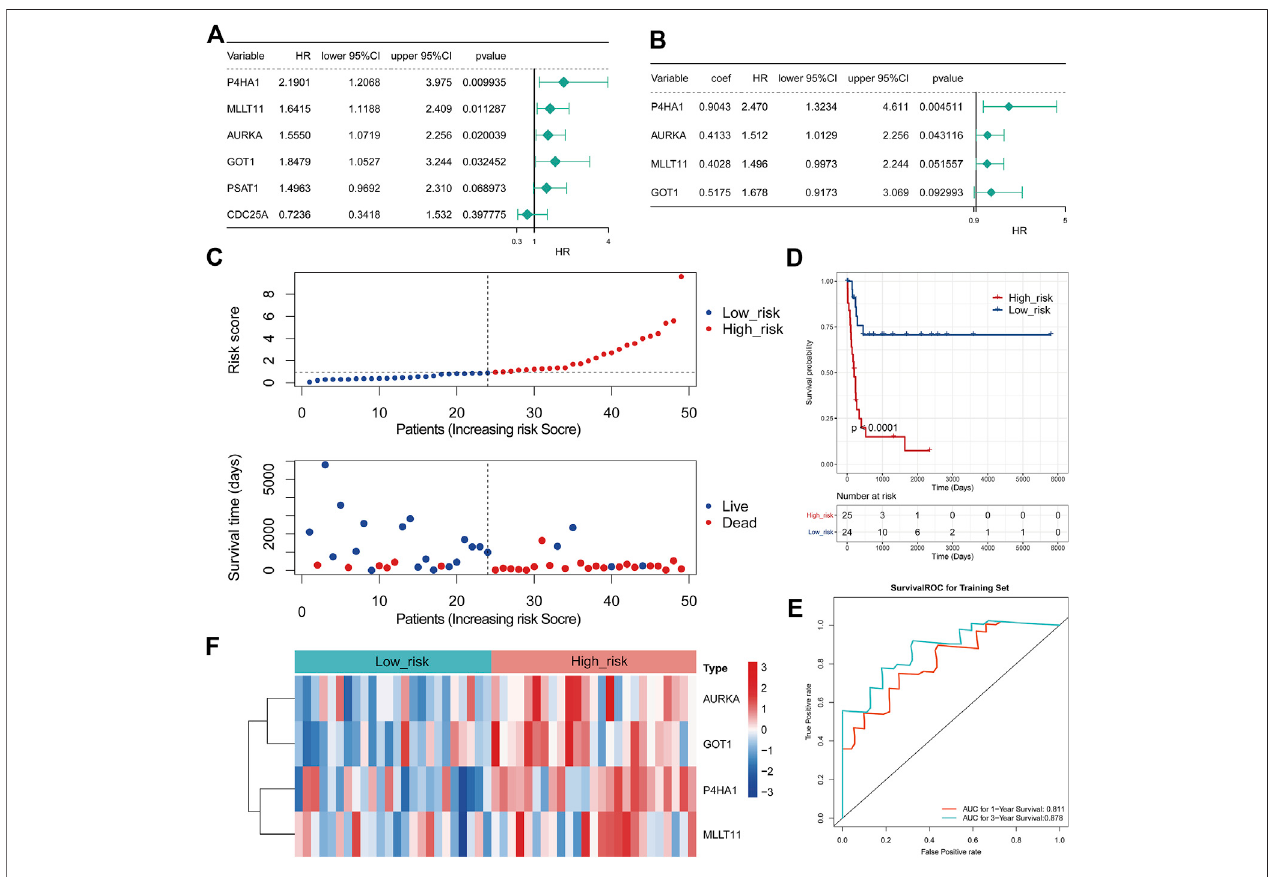
FIGURE2| DevelopmentofanmTRG-relatedgenesignatureinMRTK. (A) Forestplotofhazardratios(HRs)demonstratingtheprognosticvaluesofDE-mTRG. (B) Forest plot illustrating the multivariable Cox model results of each gene in the 4-mTRG risk signature. The dashed line was used to mark the location of HR = 1. (C) Relationship between the survival status/risk score rank and survival time (days)/risk score rank. (D) Kaplan – Meier (K-M) plot for overall survival (OS) based on the risk score ofthefour gene-based signature ofpatients withMRTK. (E) Receiver operating characteristic (ROC) curve for OSofthe TARGET-MRTK set.The areaunder curve (AUC) was assessed at 1 and 3 years. (F) Heatmap demonstrating the distribution of the four DE-mTRG expressions in the TARGET-MRTK cohort.